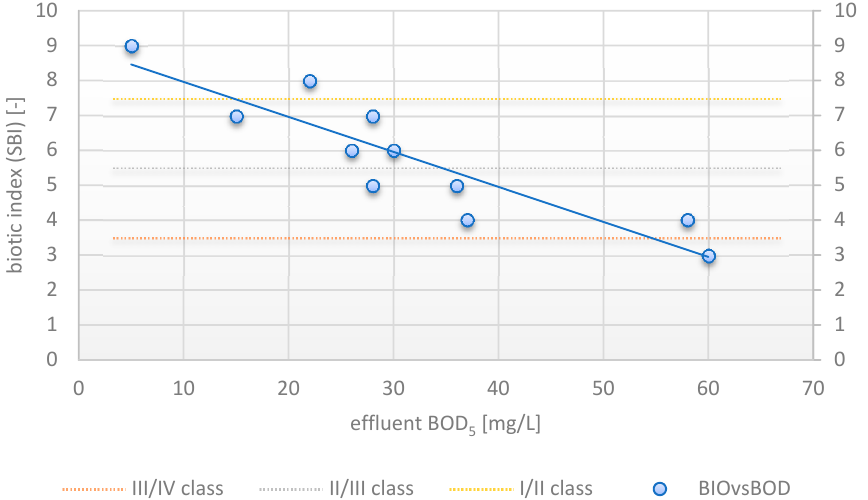
Figure 6 . Correlation between BOD 5 of the effluent and sludge biotic index in tested container on-site wastewater treatment plant. Horizontal lines mark the borders between classes of activated sludge. Each class reflects a different sludge quality (see Table 4).